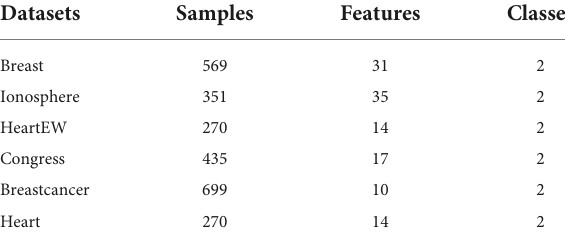
TABLE 15 Description of attributes screened by the classifiers.